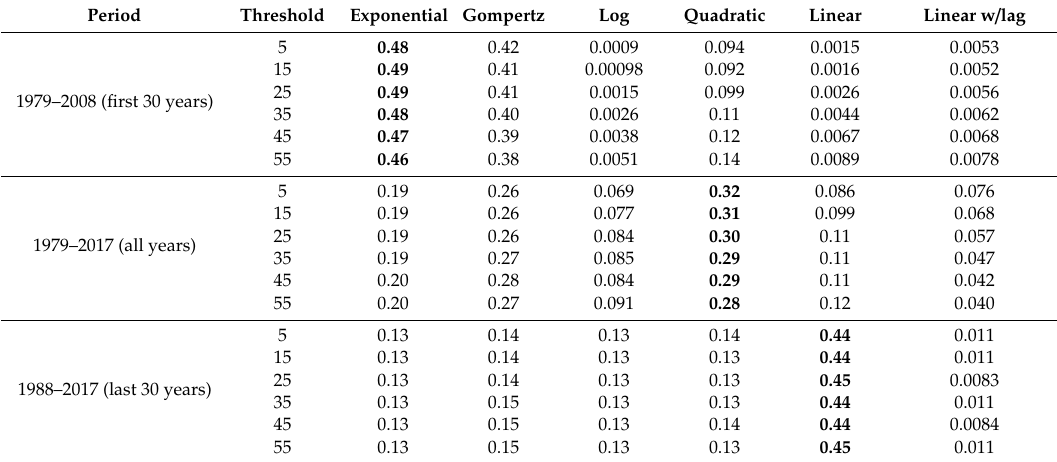
Table 1. W-Akaike weights [unitless] as calculated from Akaike information criterion corrected (AICc) values for models of annual SIE minimums. Entries in bold italics indicate the largest value, and hence optimal model, amongst models